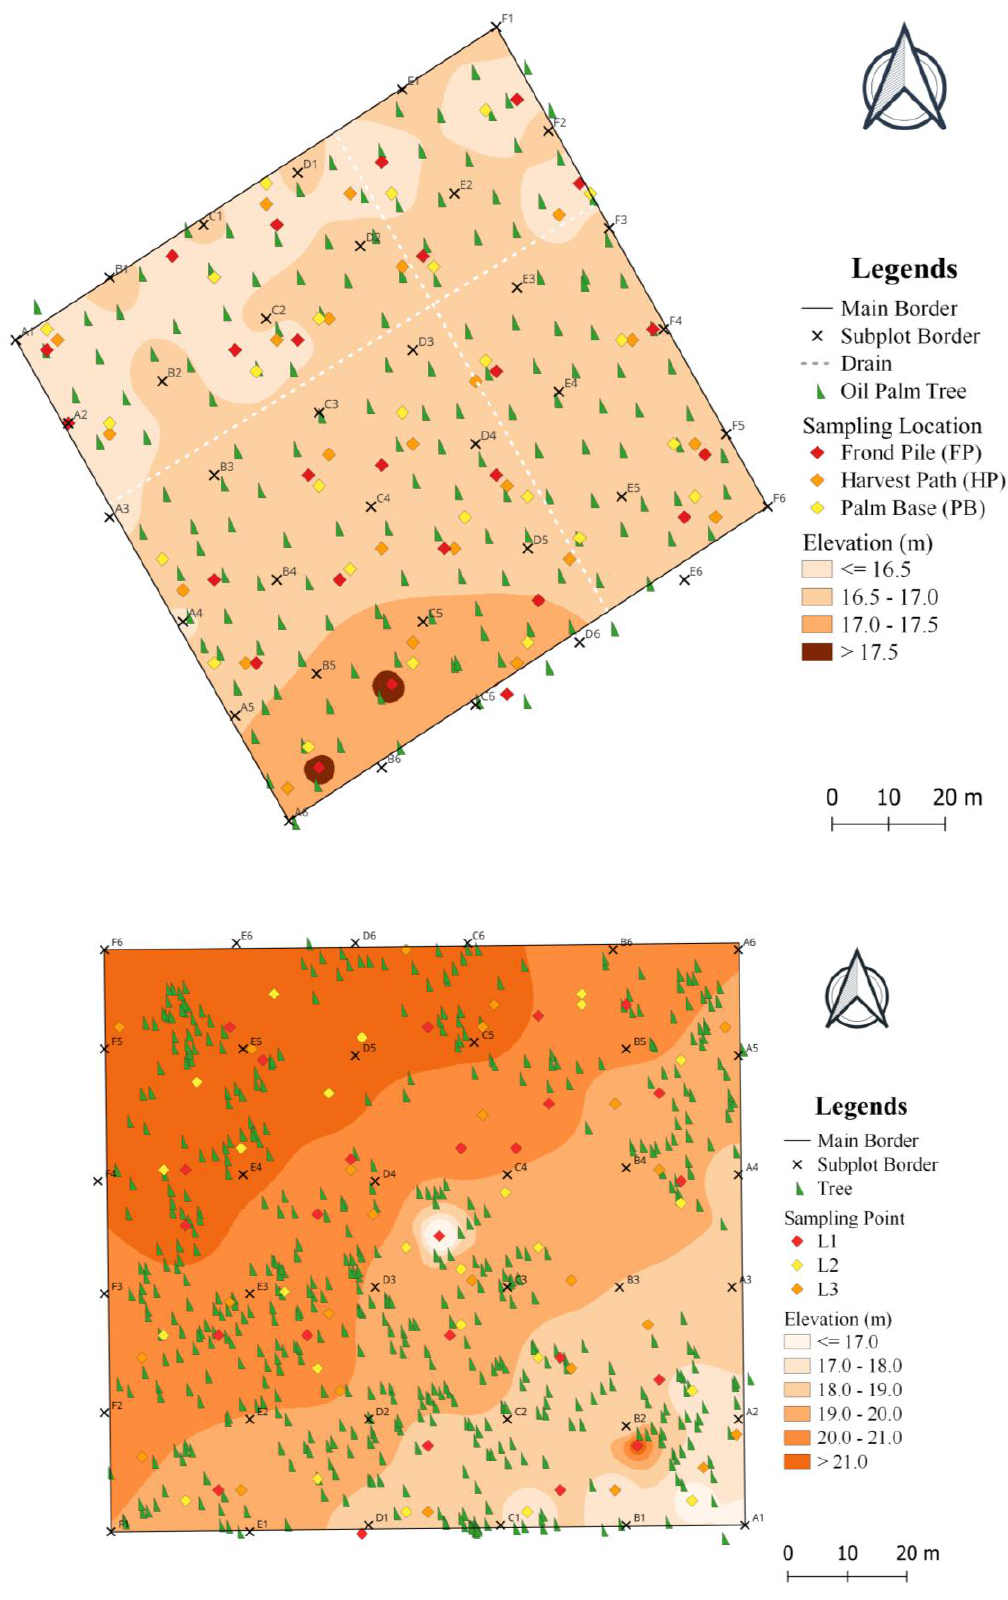
Figure 5. Maps showing the distributions of subplots, sampling points, trees and ground elevation in (a) Sebungan Estate oil palm plantation and (b) Sabaju secondary tropical peat swamp